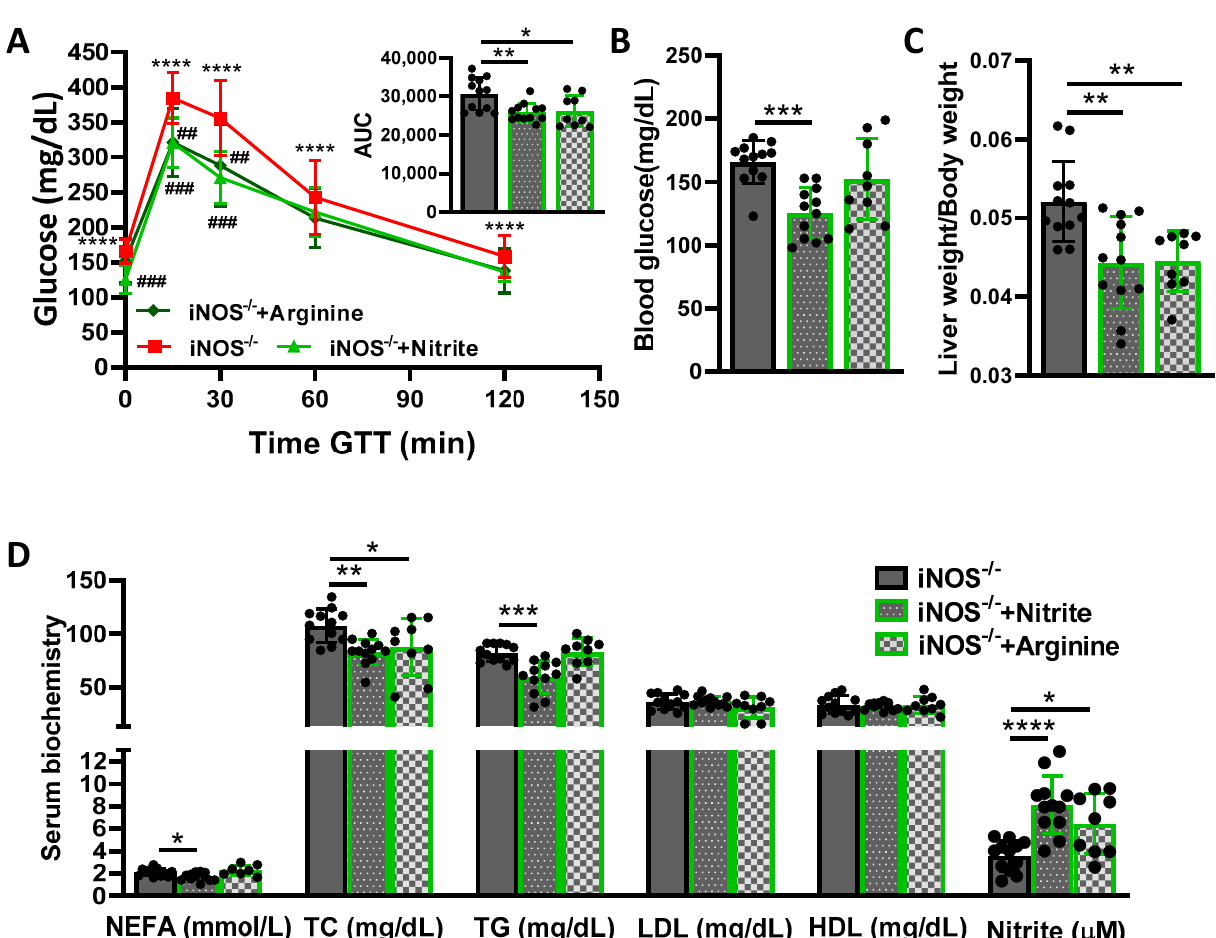
Figure 1. Effect of NO precursors on systemic glucose homeostasis and dyslipidemia in iNOS -/- mice. Systemic glucose and lipid homeostasis in iNOS -/- mice following treatment with nitrite or L-arginine. ( A ) Intraperitoneal glucose tolerance test (GTT) with AUC calculated from IPGTT data, ( B ) Fasting blood glucose levels, ( C ) Relative liver-body weight ratio and ( D ) Serum lipids and total nitrite levels. Data are represented as mean ± SD ( n = 7–12). * p < 0.05, ** p < 0.01, *** p < 0.001 and **** p < 0.0001 between indicated groups. ## p < 0.01 and ### p < 0.001 and vs. iNOS -/- in GTT curve.